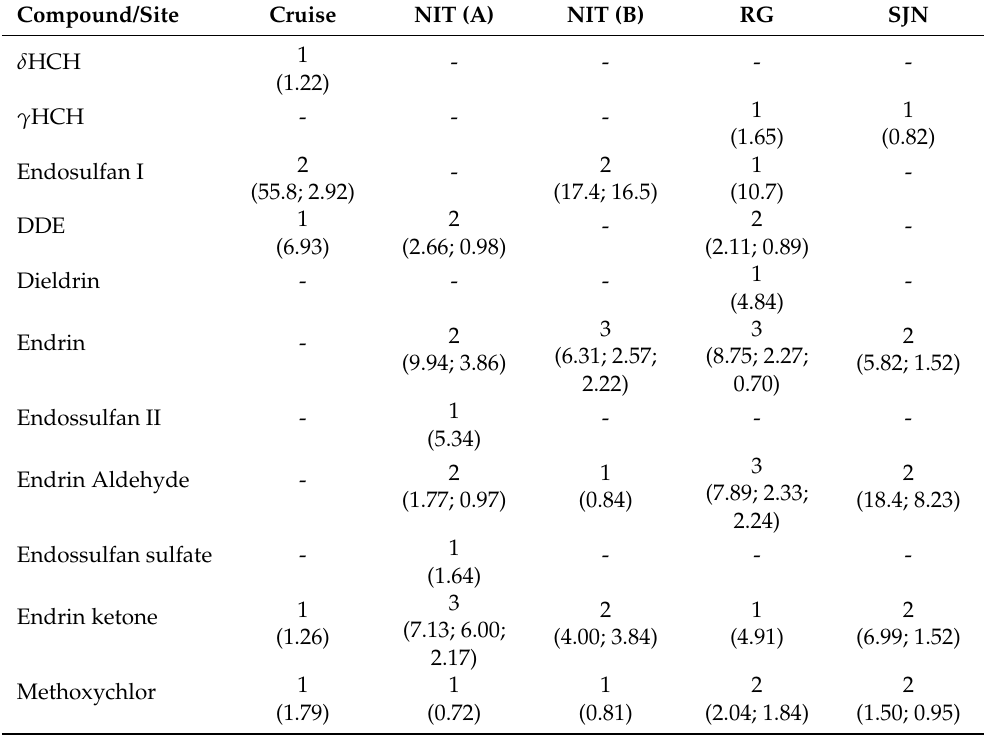
Figure 2. Box-plot graph of the concentrations of the 41 PCBs (wet weight—ww) analyzed in Sardinella brasliensis muscle samples from the five different sampling campaigns carried out herein. Table 3. Observations on the limit of quantification (n) and OCP concentrations in Sardinella brasilienses muscle tissue samples (ng g − 1 wet